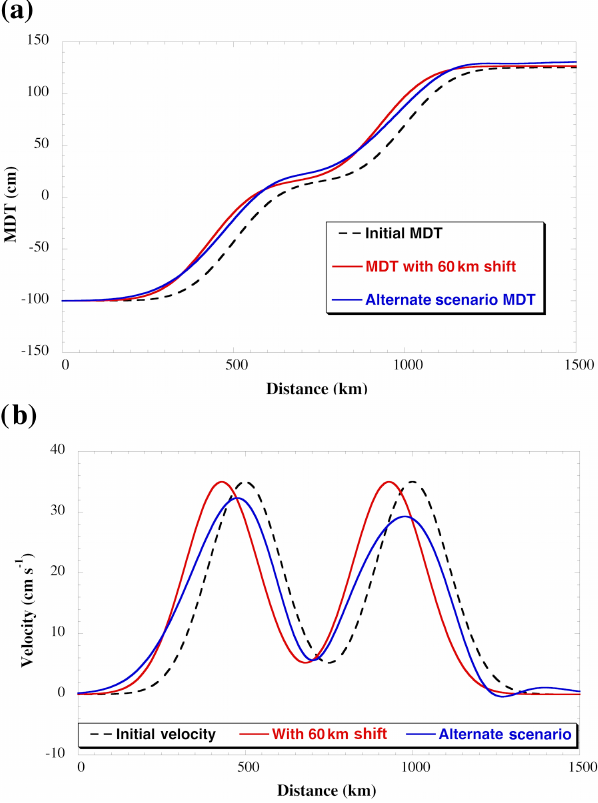
Figure 1. (a) Mean dynamic topography in the Southern Ocean along a north–south meridian for three scenarios and (b) the corre- sponding geostrophic velocity, with positive values indicating east- ward flow. The scenarios are an initial state (dashed black line), a shift in the two fronts south by 60km with no change in magnitude or shape of the currents (red line), and no shift in the mean of the current but a change in the magnitude and shape (blue